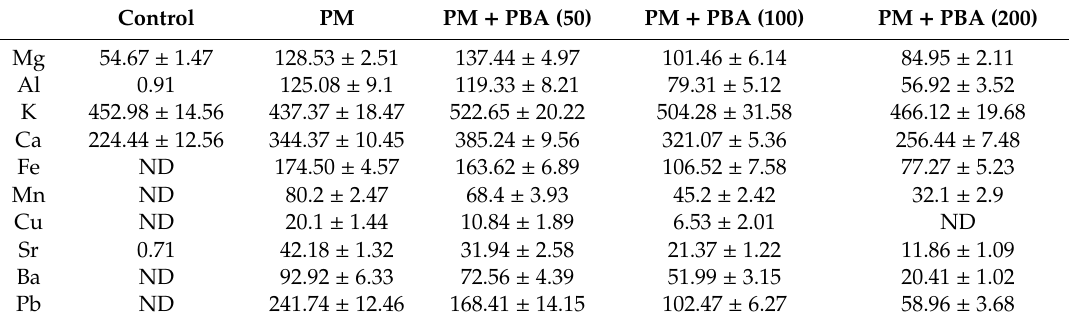
Table 2. Metal composition